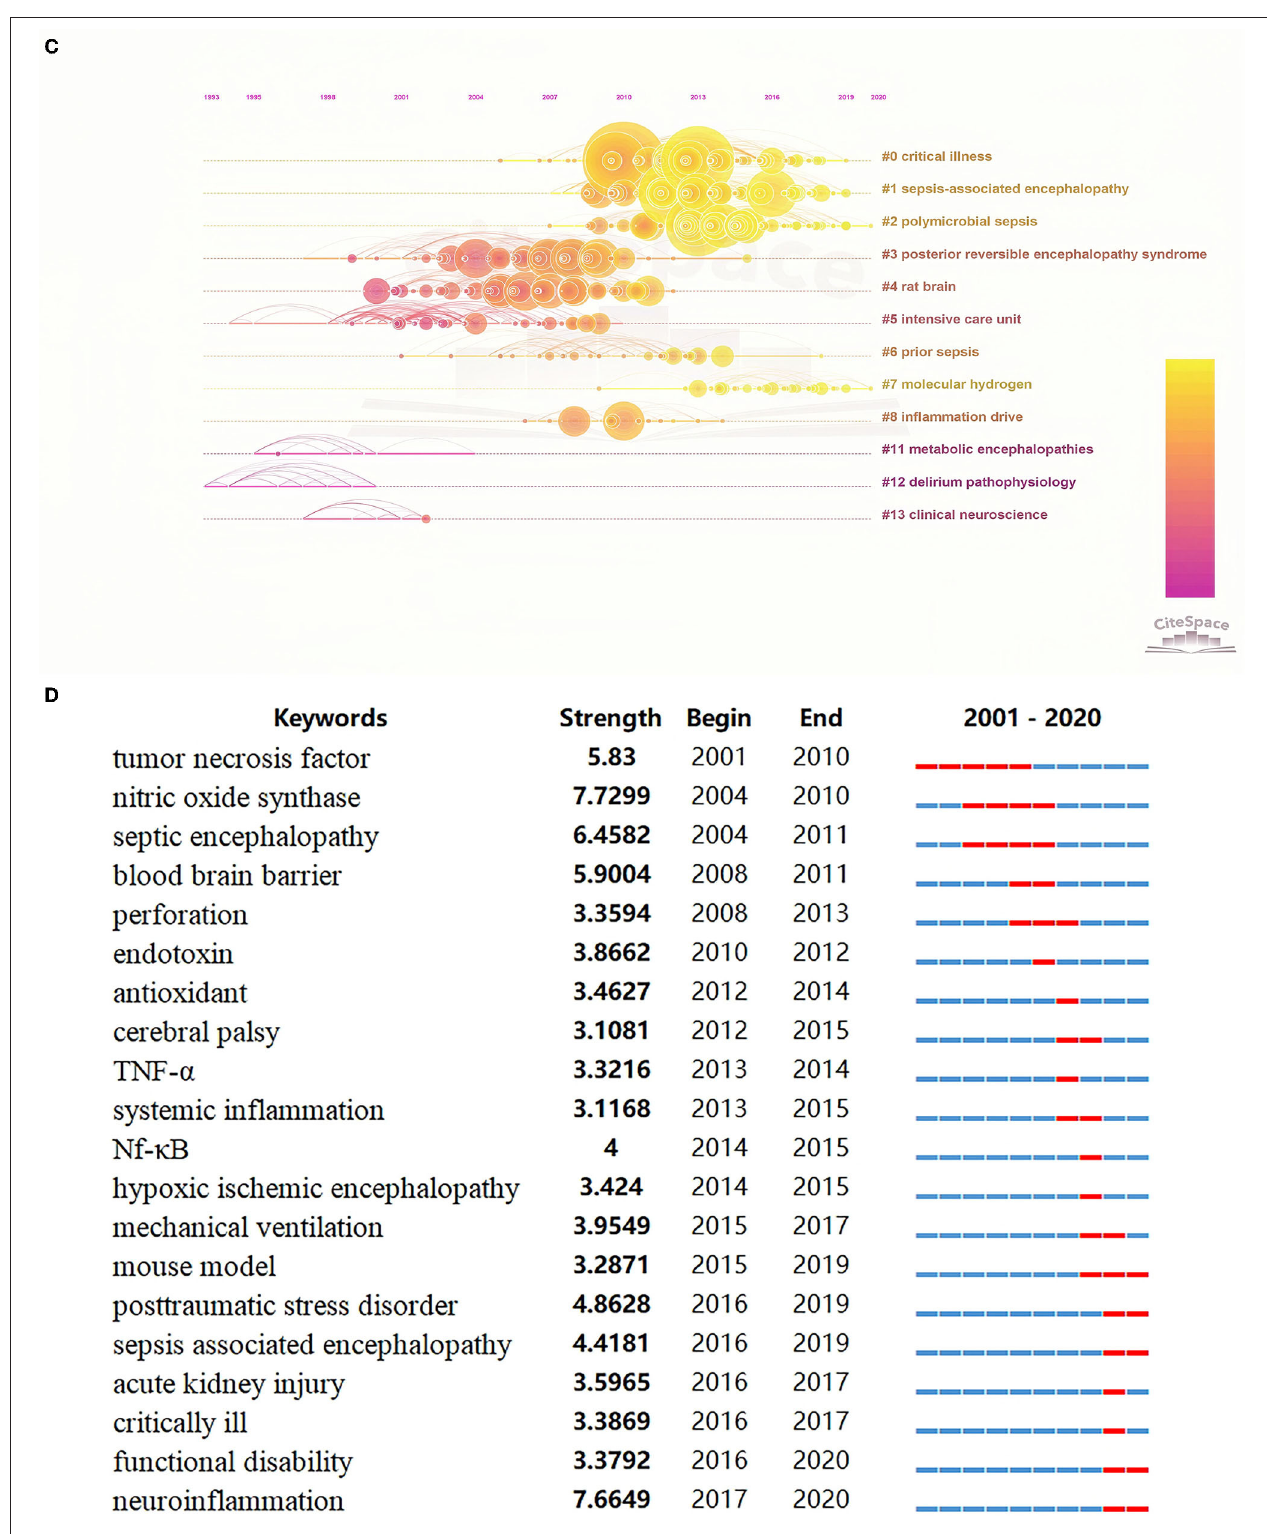
FIGURE 3 | (A) Co-citation map of references on SAE; (B) The clustered network map of co-cited references on SAE. (C) The timeline view of co-citation clusters with their cluster labels on the right. (D) Keywords with the strongest citation bursts in original articles on SAE research between 2001 and 2020.